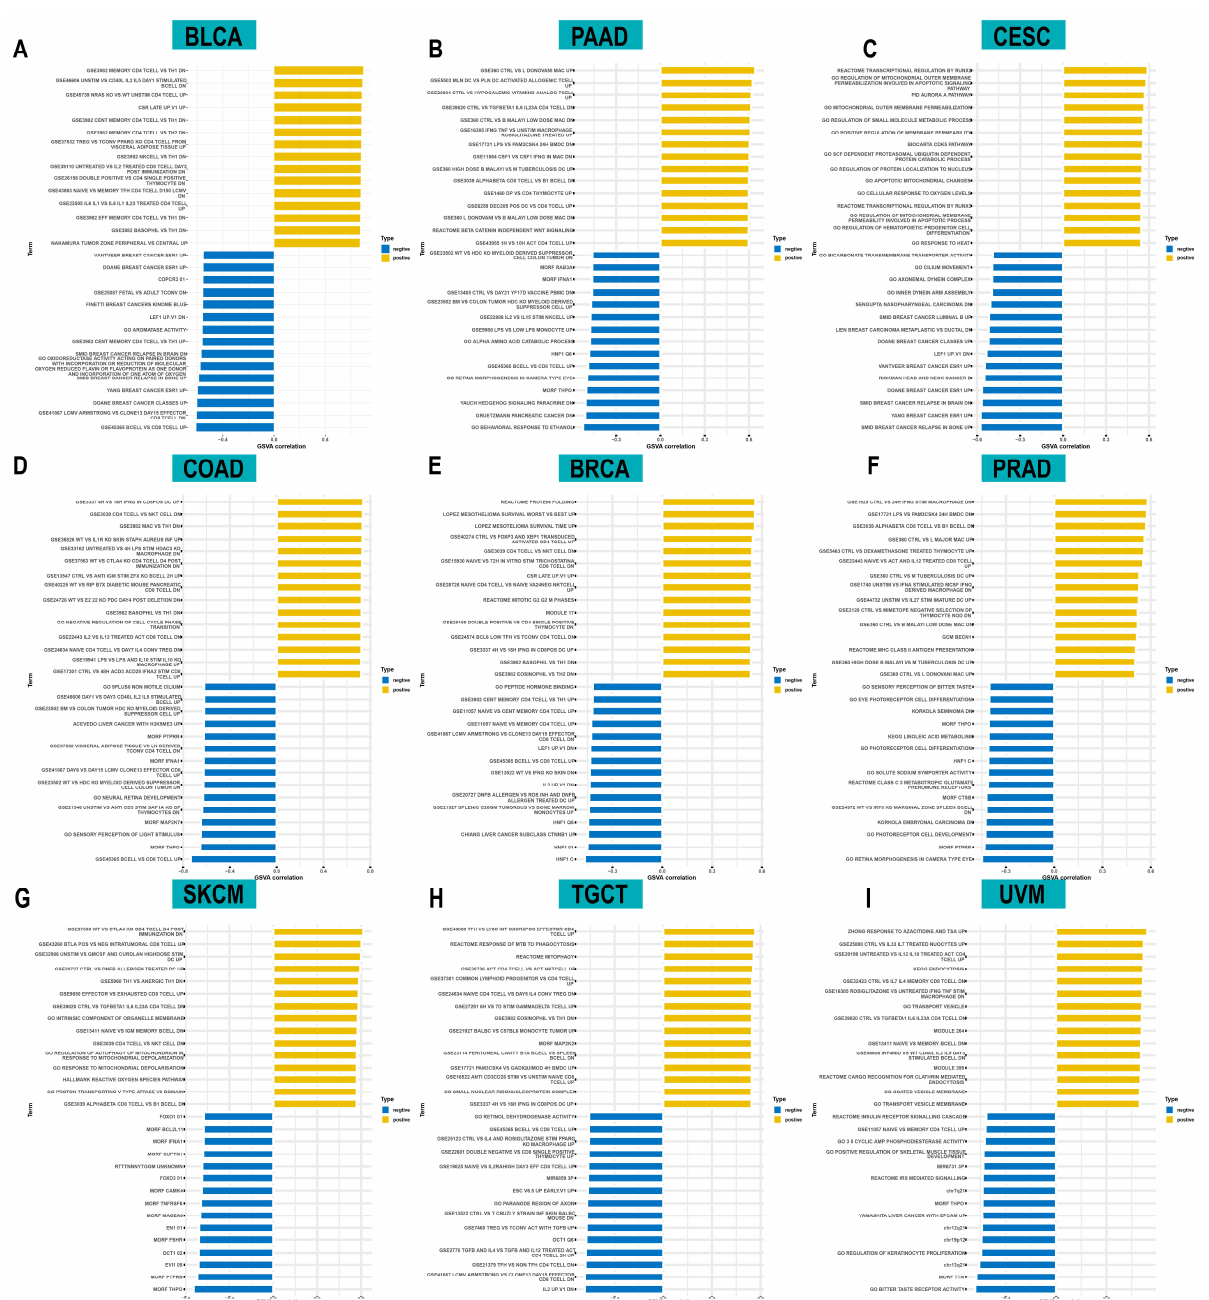
Figure 6. Results of gene set variation analysis (GSVA) in ( A ) BLCA, ( B ) PAAD, ( C ) CESC, ( D ) COAD, ( E ) BRCA, ( F ) PRAD, ( G ) SKCM, ( H ) TGCT, and ( I ) UVM.